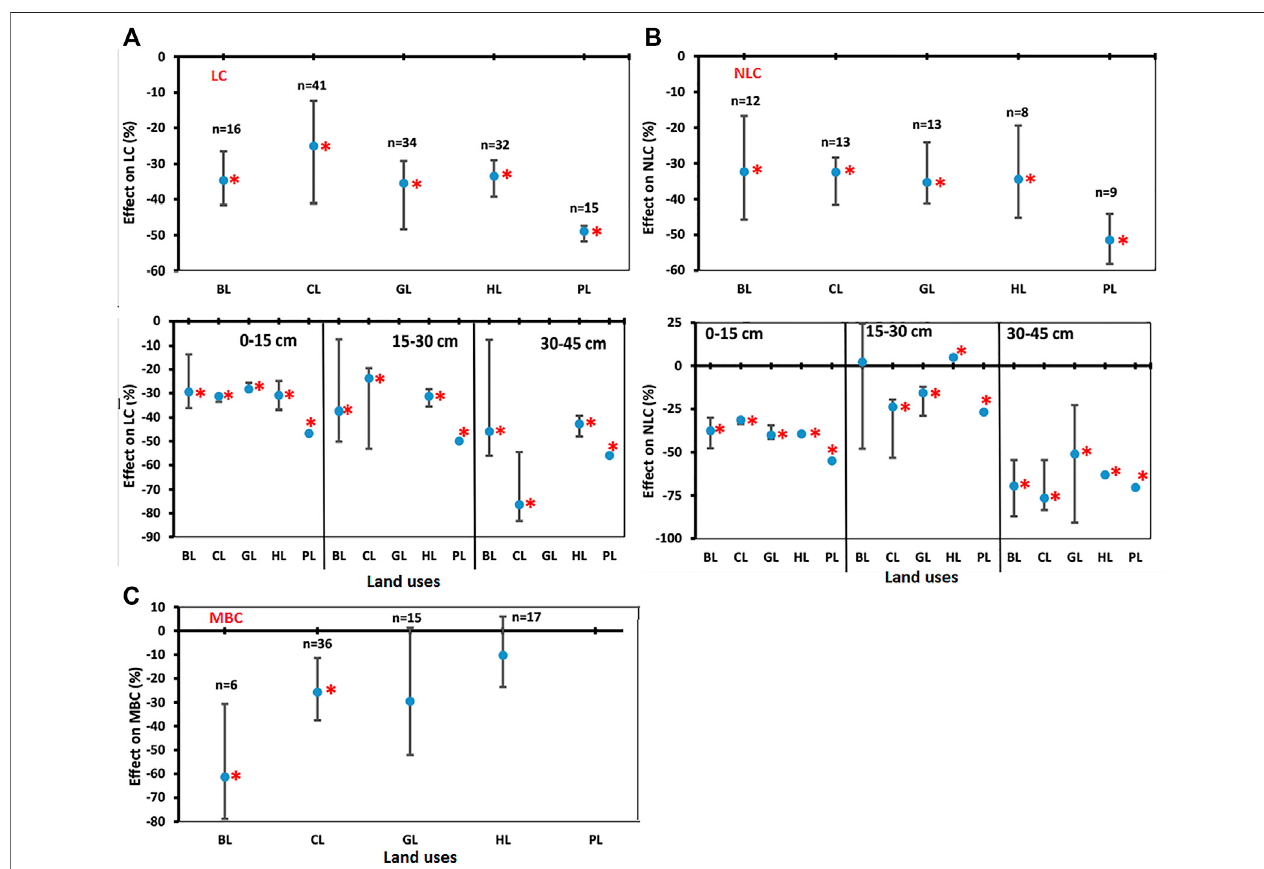
FIGURE5| Comparisonsofsoilcarbonpools(SCP). (A) Labilecarbon(LC), (B) Non-Labile carbon (NLC),and (C) MicrobialBiomass Carbon (MBC)undervarious land uses (BL, CL, GL, HL, and PL) with FL based on soil depths (0 – 15 cm, 15 – 30 cm, and 30 – 45 cm). The error bars show 95% con fi dence intervals (CI) and the difference is signi fi cant if it does not pass zero. *indicates signi fi cant difference at p -value is less than 0.05. Here, Forest land (FL) is used as control, BL — Barren land, CL — Cultivated land, GL — Grassland, HL — Horticulture land, and PL — Plantation land.